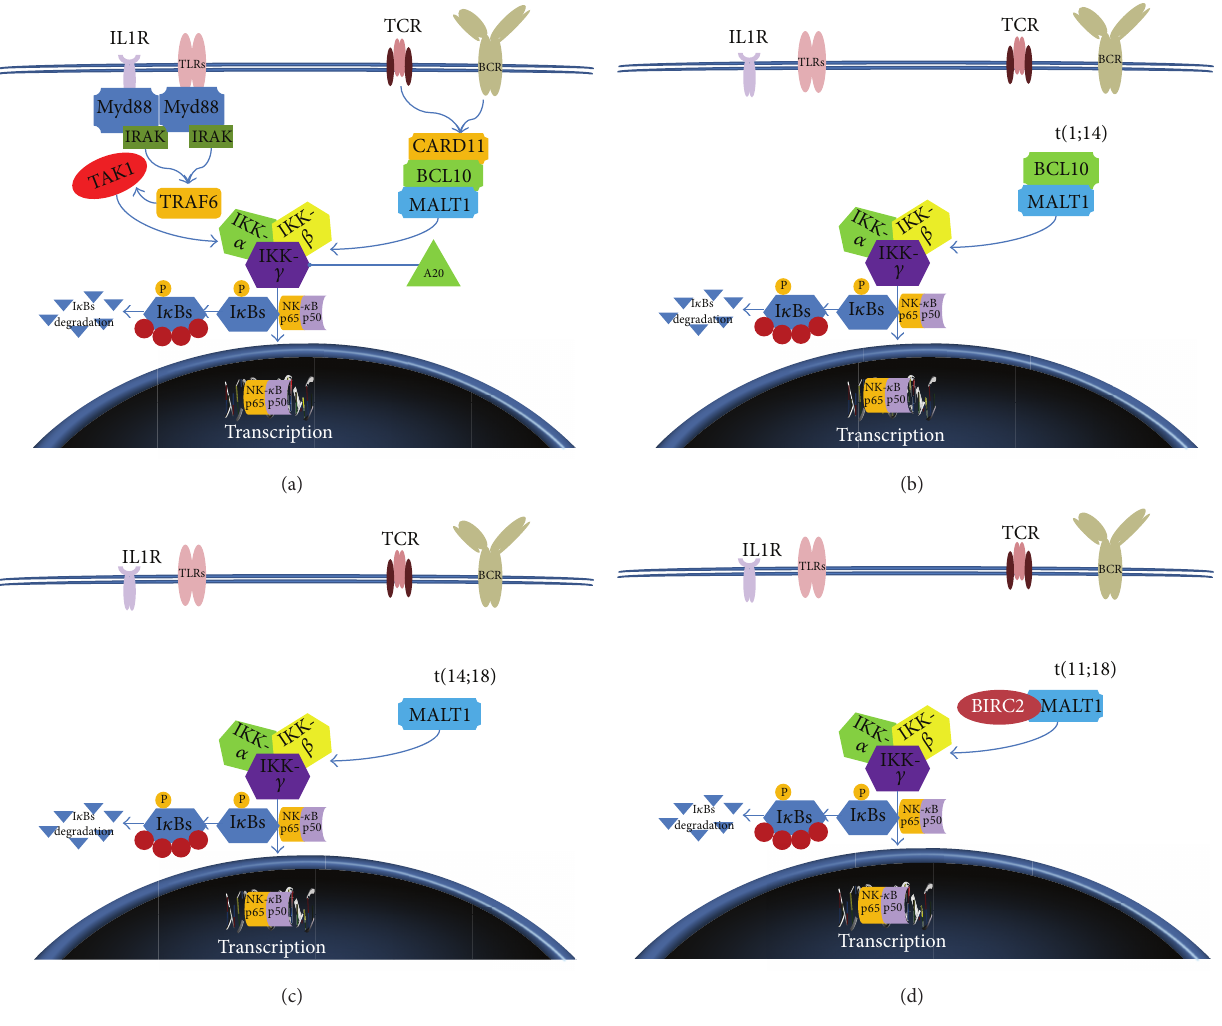
Figure 1: Translocations affecting the NF- 𝜅 B activation pathway. (a) Signaling from the TLR, IL-1R, and antigen receptor activates the canonical NF- 𝜅 B pathway, which is characterized by activation of the IKK complex, phosphorylation, and degradation of I 𝜅 B. TNFAIP3 is a negative regulator. (b) t(1;14)(p22;q32) results in the nuclear overexpression of the BCL10 protein. It is believed to form oligomers through its CARD domain and so it triggers MALT1 oligomerization and aberrant NF- 𝜅 B activation. (c) t(14;18)(q32;q21) causes overexpression of MALT1. It is thought that it oligomerizes through interaction with BCL10 causing NF- 𝜅 B activation. (d) t(11;18)(q21;q21), the BIR domain of the BIRC2-MALT1, mediates self-oligomerization leading to an activation of NF- 𝜅 B. TLR: Toll-like receptor; IL-1R: interleukin-1 receptor; BCR: B cell receptor; TCR: T cell receptor; RIP1: receptor interacting protein 1; TRAF: TNF-associated factor; TAK1: transforming growth factor beta activated kinase 1; TAB: TAK binding protein; IKK: inhibitor of NF- 𝜅 B kinase; I 𝜅 B: inhibitor of NF- 𝜅